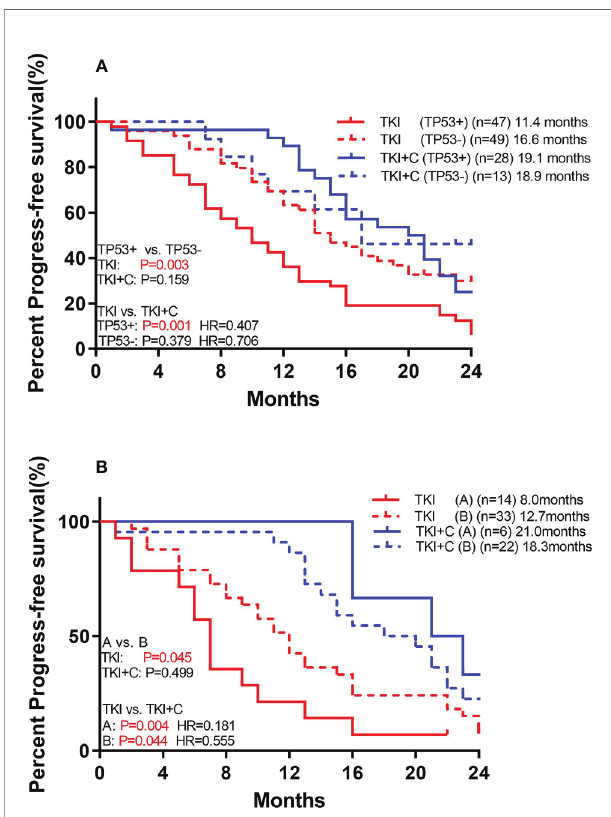
FIGURE 4 | (A) Comparison of association of concurrent TP53 mutation with PFS to monotherapy and combination therapy in patients with EGFR mutation (B) Comparison of association of TP53 subtypes with PFS to monotherapy and combination therapy in patients with EGFR mutation. [Group (A) included exon 4 and 6. Group (B) included the remaining mutant types].